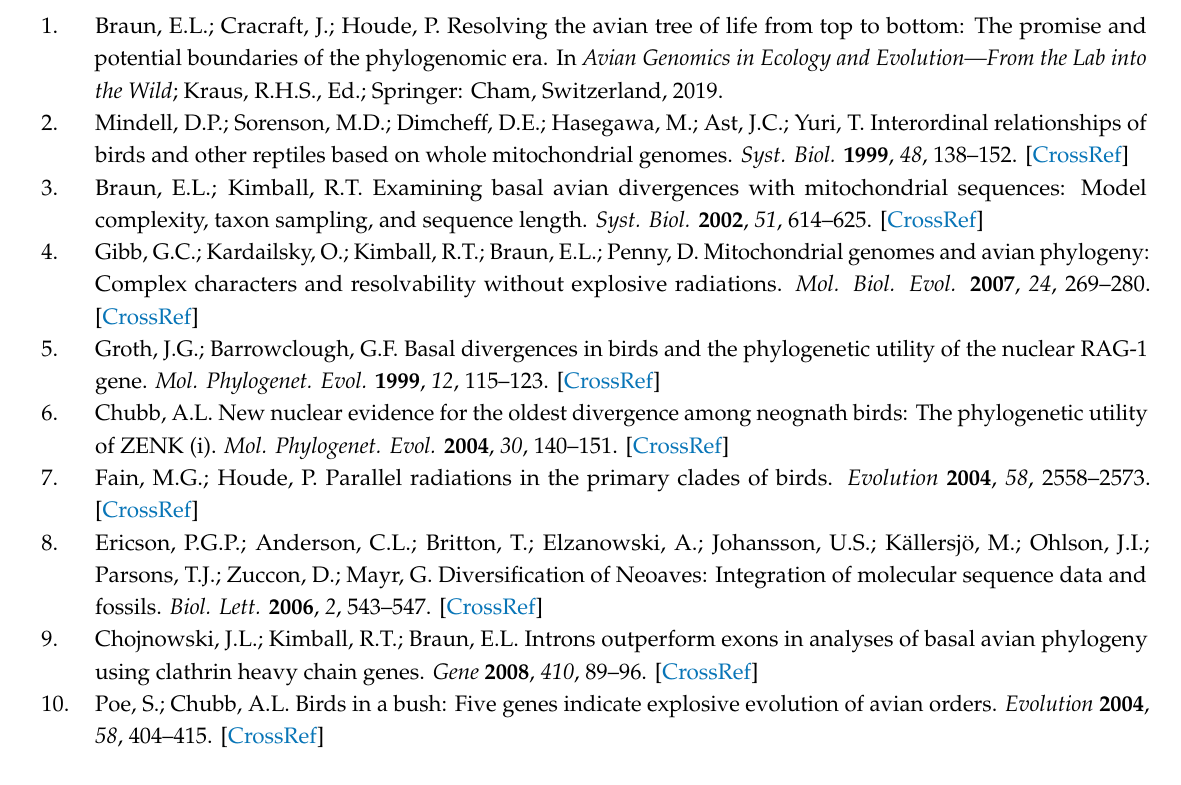
were treated as strict consensus) and 10,000 bootstrap replications. Bootstrap scores are shown only for branches with < 100% support, Figure S3: Bootstrap Maximum Parsimony tree of concatenated UCE indels, Figure S4: Bootstrap Maximum Parsimony tree of concatenated exon indels, Figure S5: Bootstrap Maximum Parsimony tree of concatenated intron + UCE + exon indels, Figure S6: Best Maximum Likelihood tree of concatenated intron indels using the BINGAMMA model in RAxML [1], from 10 randomized starting MP trees ( − 10 option), Figure S7: Best Maximum Likelihood tree of whole genome indels using the BINGAMMA model in RAxML [1], Figure S8: Intron indel and nt gene tree ensemble RI as a function of number of characters per locus, Figure S9: Gene tree Robinson-Foulds (RF) distances for intron and uce gene trees, Figure S10: Quartet Scores of intron indel ASTRAL tree. Right panel: Collapsed intron indel 5% ASTRAL tree, Figure S11: Quartet Scores of intron nt ASTRAL tree. Right panel: Collapsed intron nt 5% ASTRAL tree, Figure S12: Quartet Scores of UCE indel ASTRAL tree. Right panel: Collapsed UCE indel 5% ASTRAL tree, Figure S13: Quartet Scores of UCE nt ASTRAL tree. Right panel: Collapsed UCE nt 5% ASTRAL tree, Figure S14: Polytomy test of intron indel dataset [11] conducted using ASTRAL III [12], Figure S15: Polytomy test of intron nt dataset [11] conducted using ASTRAL III [12], Figure S16: Polytomy test of combined intron indel + nt dataset [11] conducted using ASTRAL III [12], Figure S17: Polytomy test of UCE indel dataset [11] conducted using ASTRAL III [12], Figure S18: Polytomy test of the UCE nt dataset [11] conducted using ASTRAL III [12], Figure S19: Polytomy test of the combined UCE indel + nt dataset [11] conducted using ASTRAL III [12], Figure S20: Polytomy test of the combined intron + UCE indel dataset [11] conducted using ASTRAL III [12], Figure S21: Polytomy test of the combined intron + UCE nt dataset [11] conducted using ASTRAL III [12], Figure S22: Polytomy test of the combined intron + UCE indel + nt dataset [11] conducted using ASTRAL III [12], Table S1: Distribution of indels per intron per size class. Data and code used in this paper can be found at http: // doi.org / 10.5281 /